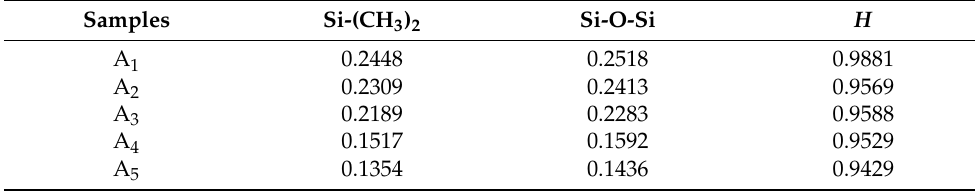
Table 3. The absorption peak height ratio of Si-O-Si and Si(CH 3 ) 2 of composite insulator in A.